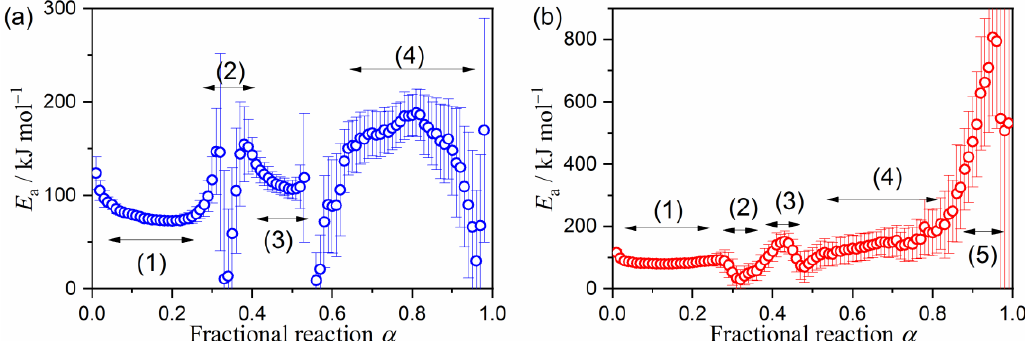
Figure 5. The apparent E a values at different α with reference to the total mass-loss during the overall thermal decomposition of the purified clay minerals, determined by the Friedman plot: ( a ) Palygorskite and ( b )